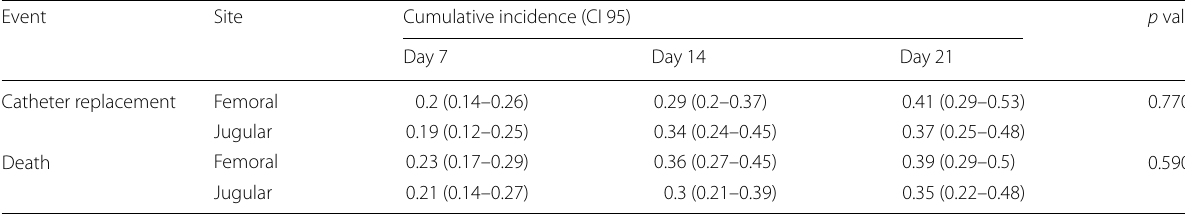
Table 4 Cumulative incidence of catheter replacement and death according to insertion site (first catheter, jugular or femoral)